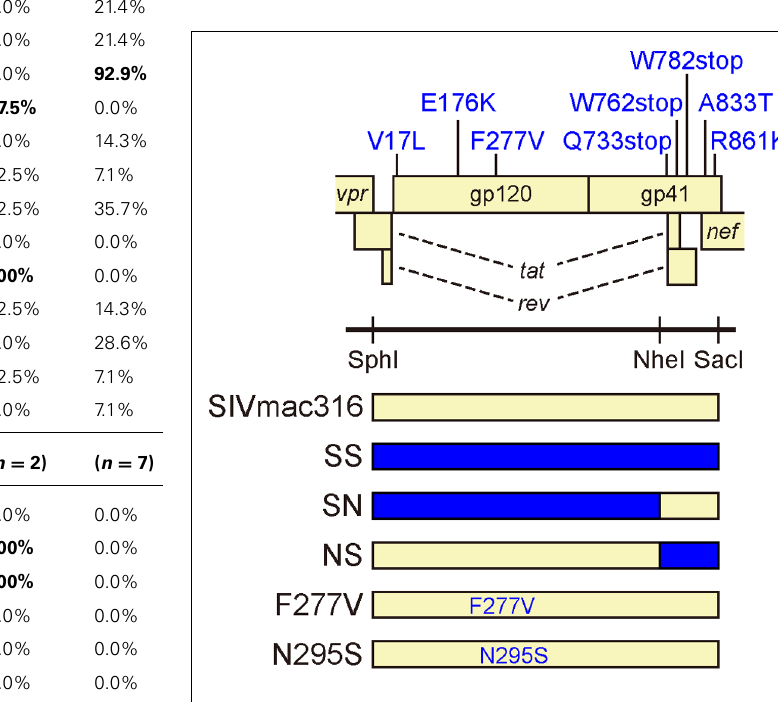
FIGURE 2 | Construction of infectious SIV clones with B404-resistant mutations. The open reading frames of the SIV genome are shown along with the Env substitutions in the B404-resistant variant typical to P26B404I. Full-length SIV clones were constructed from parental SIVmac316 by replacing the env region with that of the B404-resistant variant (blue) using Sph I, Nhe I, and Sac I sites.The resultant virus SS contains all of the Env substitutions present in P26B404I.Viruses SN and NS contain substitutions in gp120 and gp41, respectively. Point mutants F277V and N295S were constructed by inserting the substitutions F277V and N295S into SIVmac316,